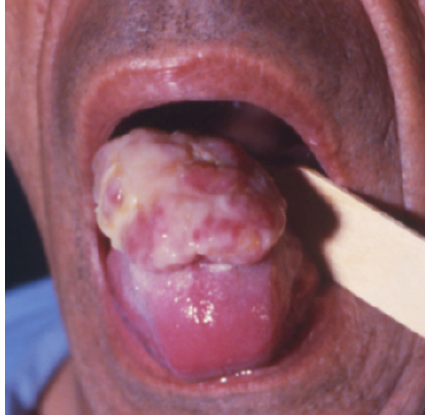
Figure 2. Large fungating mass affecting the middle portion of the tongue, with variegated white-yellowish to red discoloration.